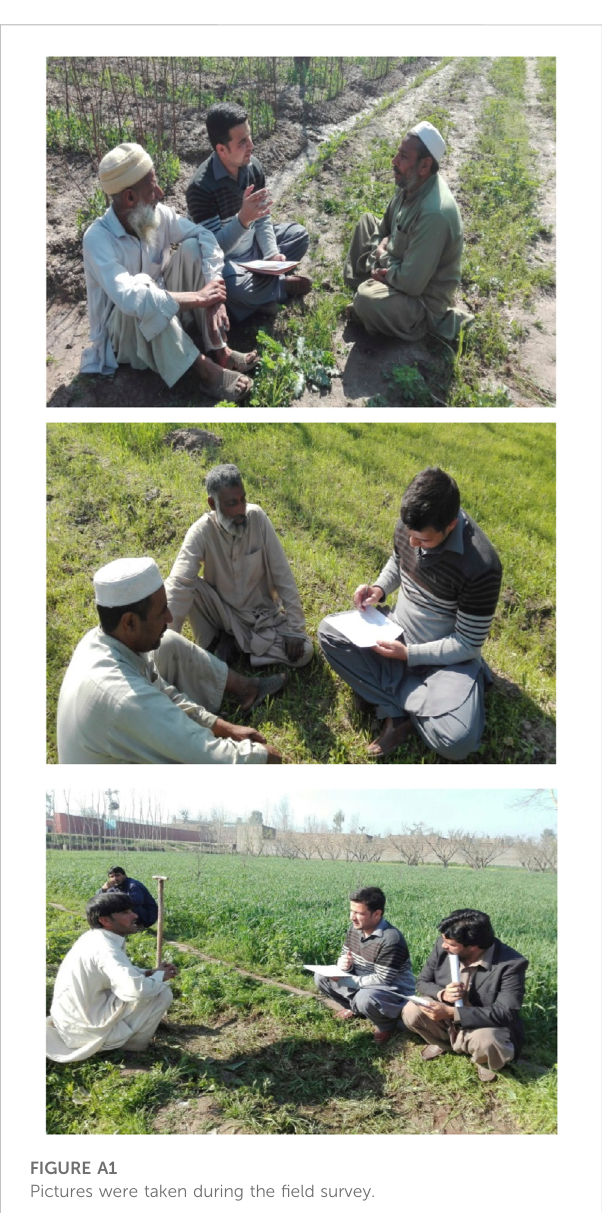
FIGURE A1 Pictures were taken during the fi eld